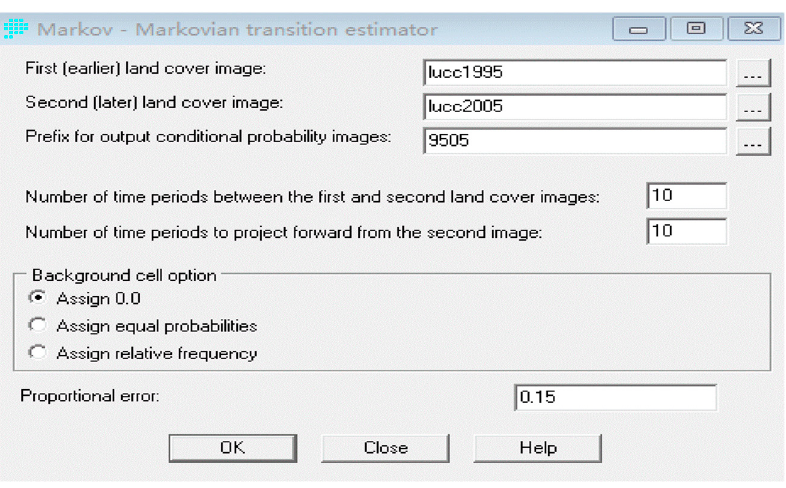
Figure 6. Calculation of land use probability transfer matrix by Markov module.